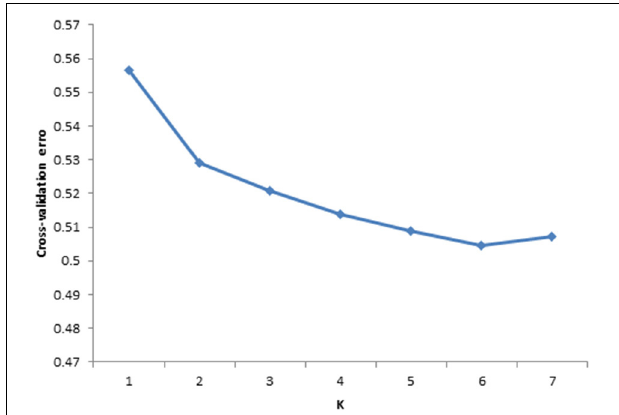
FIGURE 2 | Cross validation plot for six cattle breeds in South Africa. Based on cross validation error the plot indicated that k = 6 is optimal for data set.